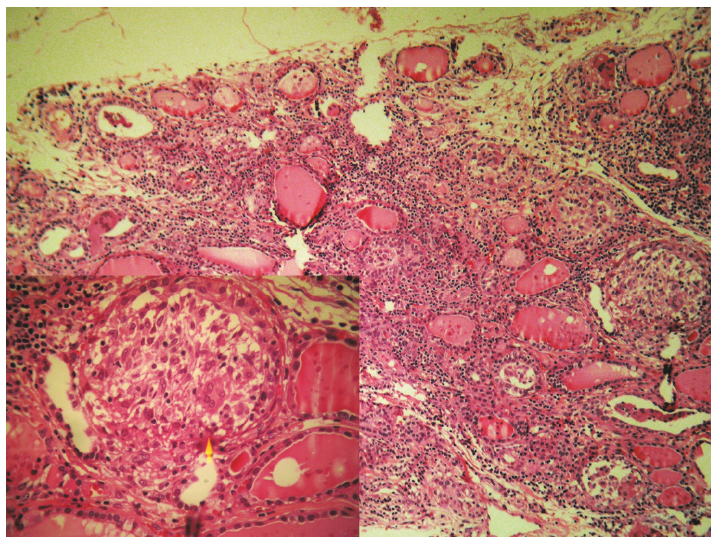
Figure 2: Granulomas in the thyroid (HEx100): the arrow shows epithelioid and langhans giant cells (HEx400).